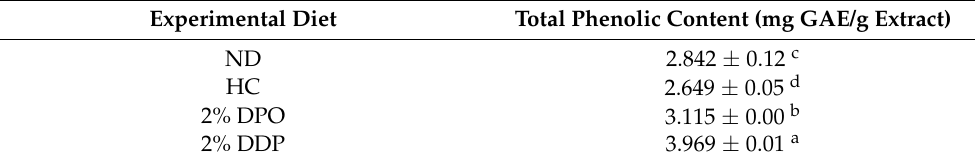
Values are the mean ± standard deviation ( n = 3). Different letters indicate significant differences ( p < 0.05) between groups by Duncan’s multiple range tests. ND: normal diet; HC: high cholesterol diet; 2% DPO: 2% dabai